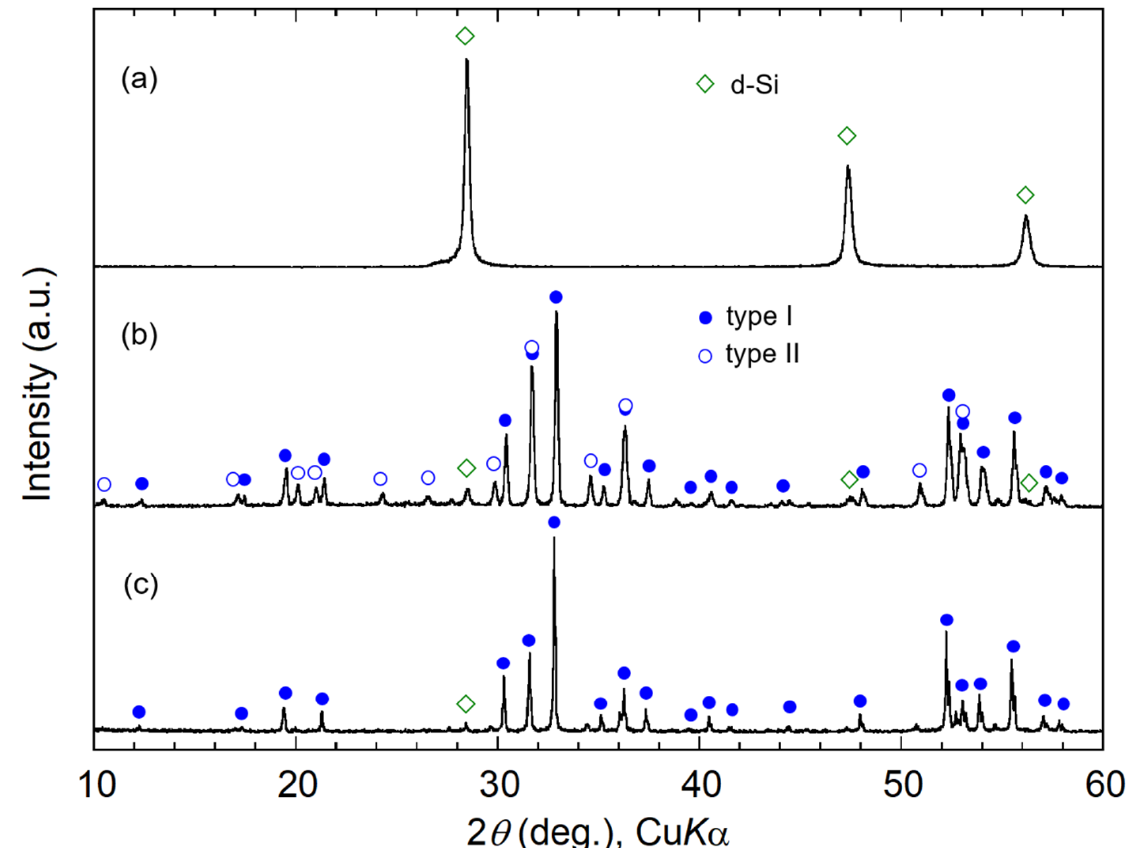
Figure 4. XRD patterns of the samples prepared by heating the Na 4 Si 4 bulk sample without a Sn flux at temperatures of ( a ) 723 and ( b ) 673 K for 15 h under a pressure of 10 Pa. ( c ) XRD pattern of the sample prepared by heating the Na 4 Si 4 powder without a Sn flux at 723 K for 15 h under a pressure of 10 4 Pa.